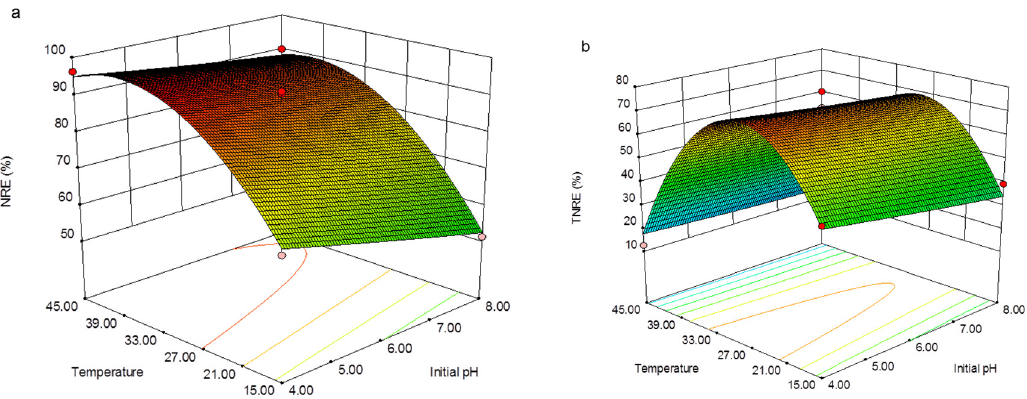
Figure3. Responsethree-dimensional(3D)-surfaceplotof( a )NREand( b )TNREatdi ff erenttemperature Figure 3. Response three-dimensional (3D)-surface plot of ( a ) NRE and ( b ) TNRE at different versus initial temperature versus initial pH.